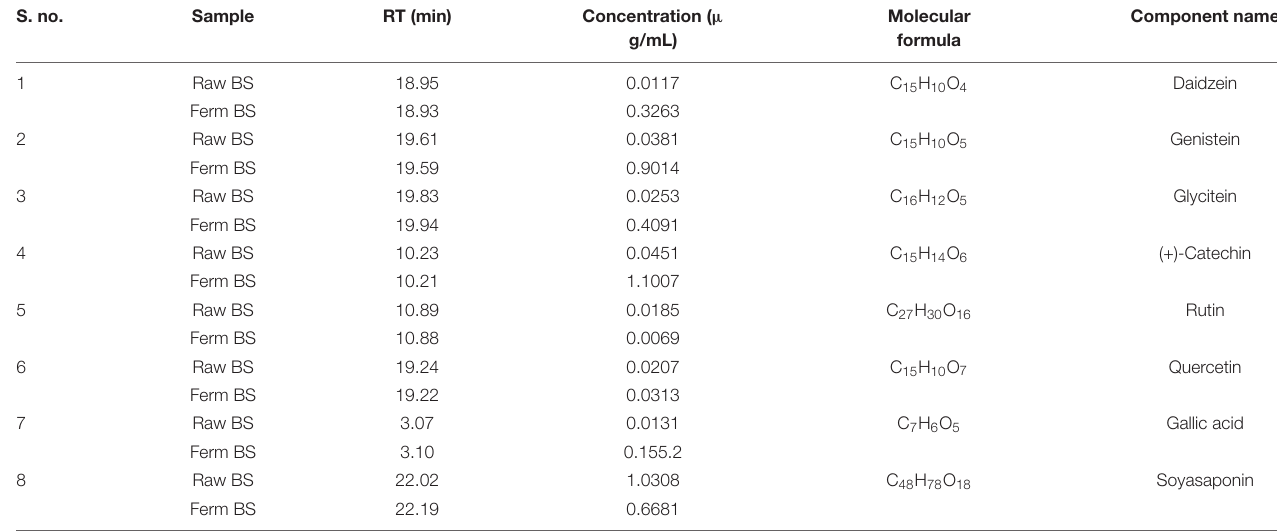
TABLE 2 | Quantification of some of the bioactive compounds in non-fermented and fermented black soybean samples by UHPLC-ESI-QTOF-MS 2 . S. no. Sample RT (min) Concentration ( µ